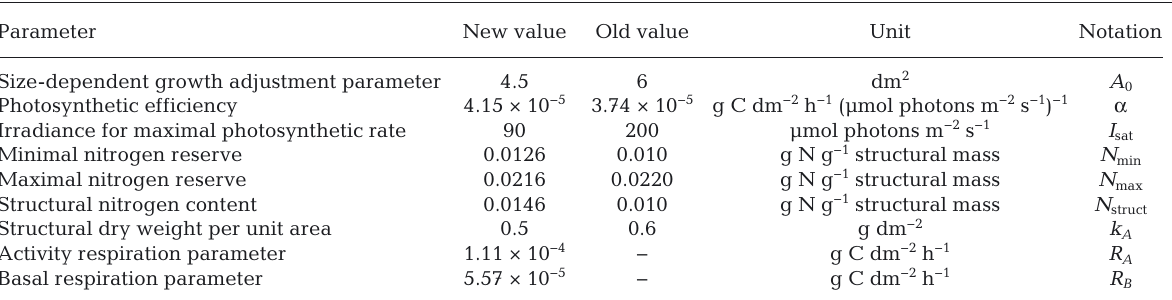
Table 3. New (present paper) and old (Broch & Slagstad 2012) values for parameters adjusted by tuning the Saccharina latis- sima model to the data (cf. ‘Mesocosm growth experiment’). Only the parameters that were changed have been included here. For notations and the rest of the parameters, see Broch & Slagstad (2012)